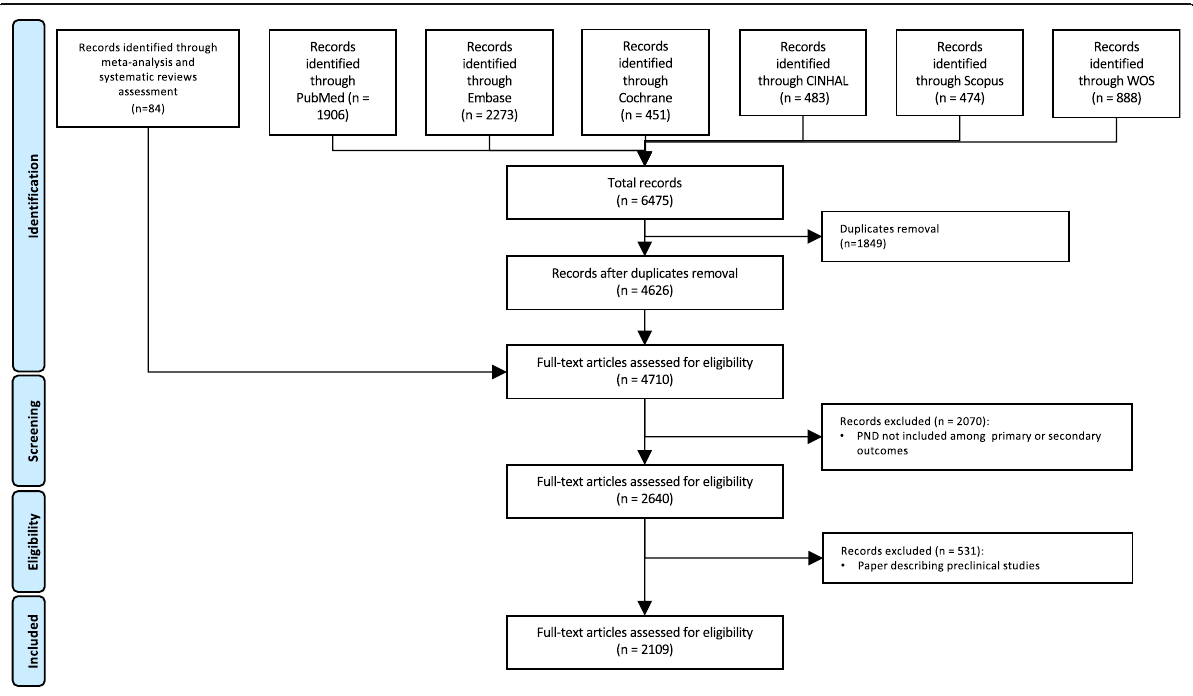
Fig. 1 Flow chart describing the studies selection